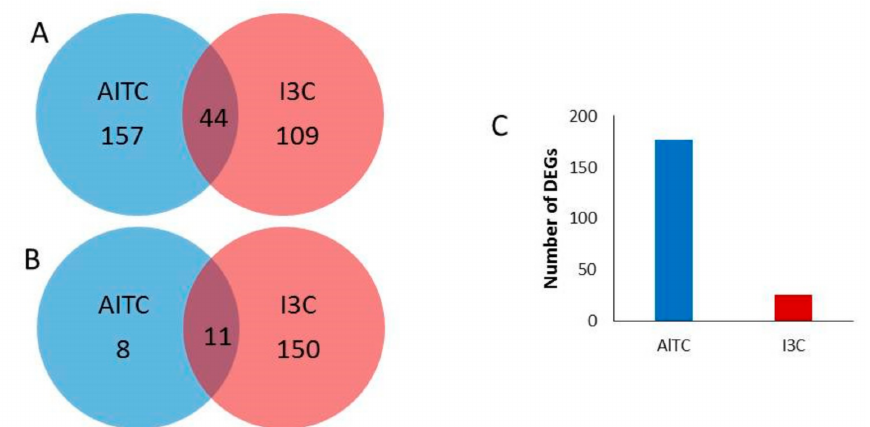
Figure 2. Venn diagrams showing overlapping ( A ) upregulated differentially expressed genes (DEGs) and ( B ) downregulated DEGs between the comparisons of AITC vs. the control and I3C vs. the control. ( C ) Number of upregulated DEGs by AITC or I3C in the comparison of AITC vs. I3C. DEGs were identified based on a false discovery rate ≤ 0.05 and − 1 ≤ log 2 fold change ≥ 1. DEGs glgx, glgz, glgb1, glgb2 malQ, maK, and glgE controlling the synthesis of glucans were induced by one or both GHPs (Figure 3). TreA and treS were induced by both GHPs and they are related to the metabolism of trehalose (Figure 3).